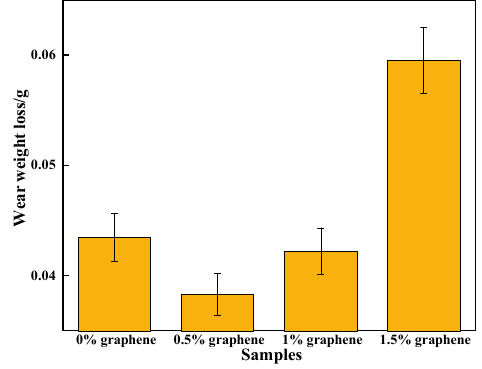
Figure 12. Wear curve of the cladding layer.